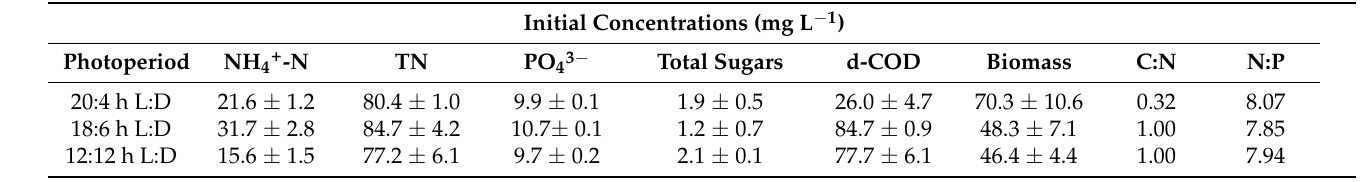
Table 10. Initial biomass and nutrient concentrations in the experimental sets for optimum photope- riod investigation.